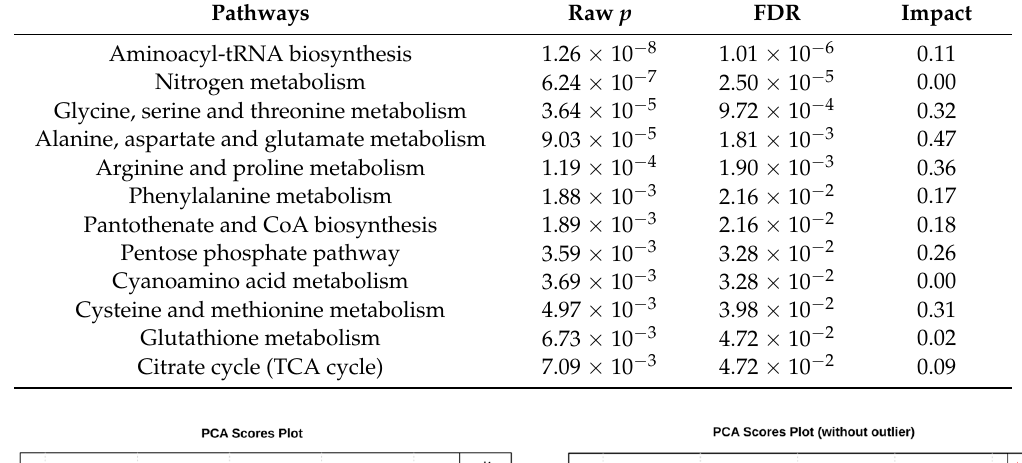
Table A4. Significant altered metabolic pathways. Raw p is the original p value calculated based on enrichment analysis; FDR is the p value after correction by FDR; Impact is the pathway impact value calculated from pathway topology analysis [36].